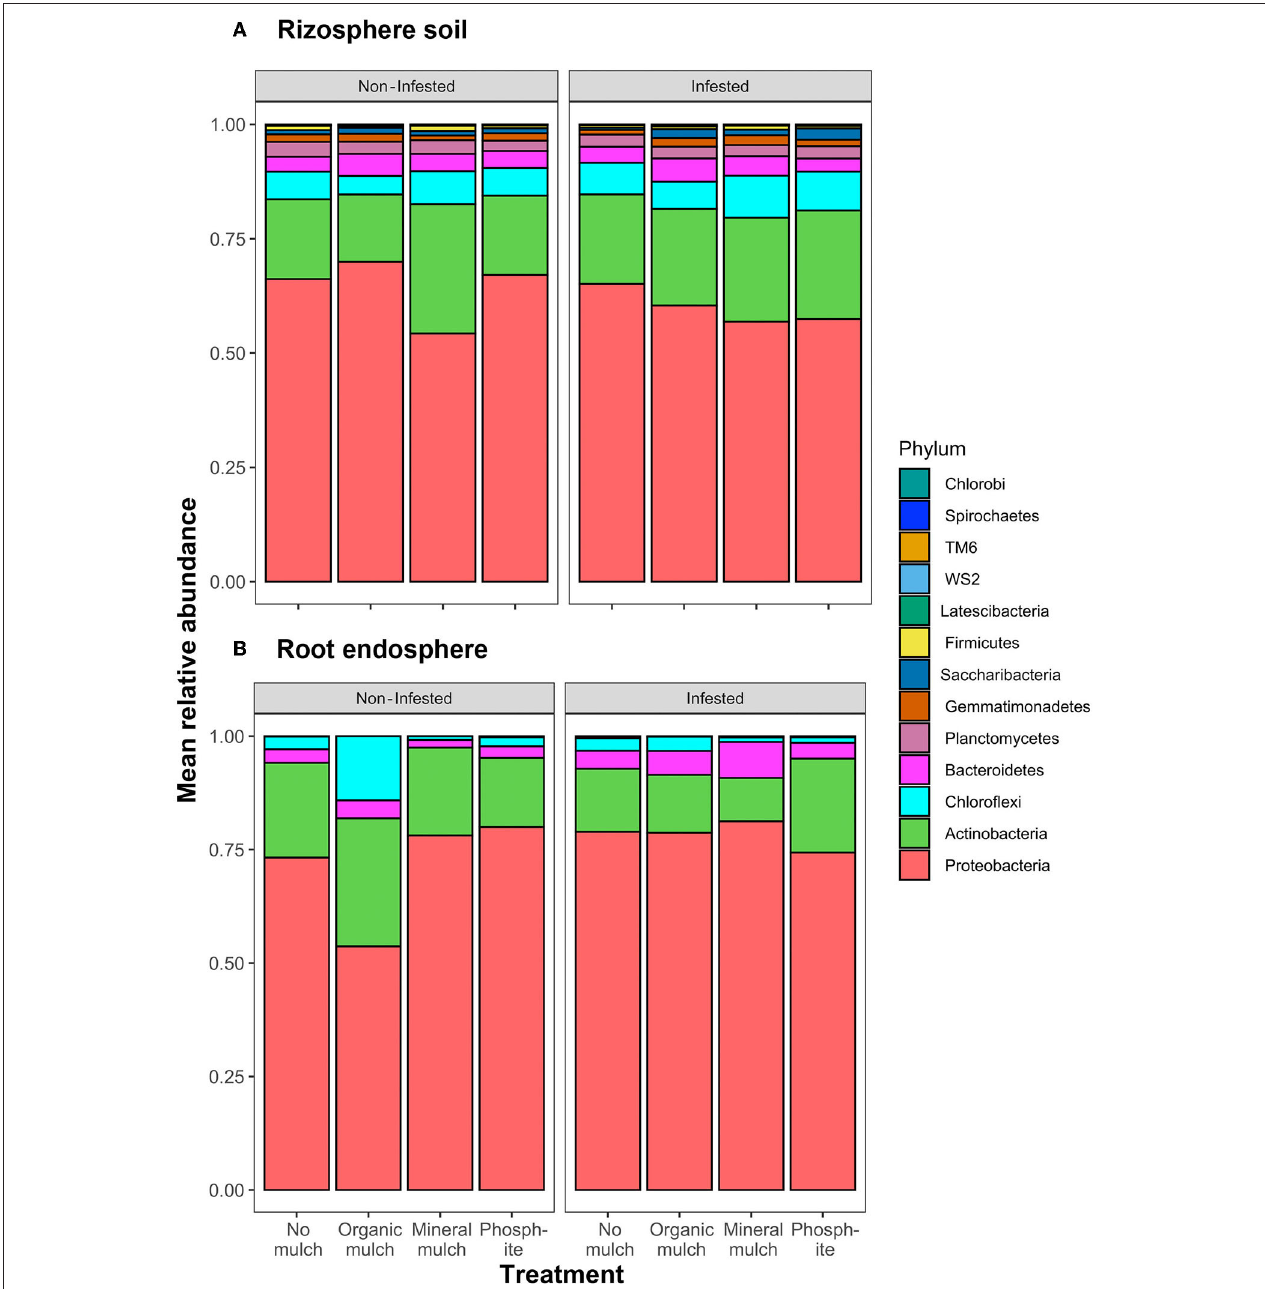
FIGURE 4 | Relative abundance of phyla across the four treatments and comparing infested and non-infested plants in (A) rhizosphere soil and (B) root